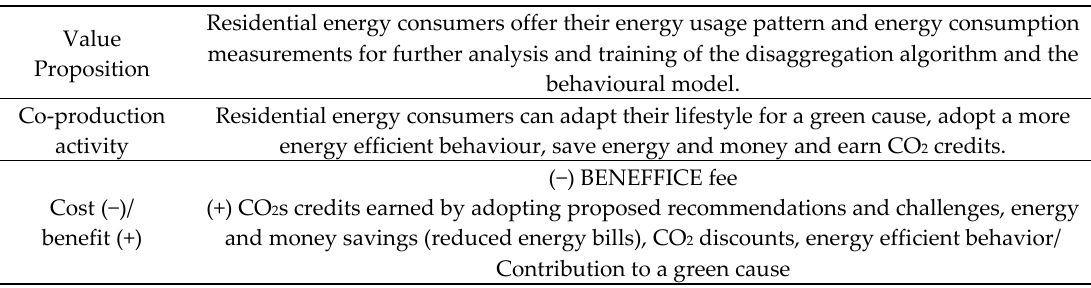
Table 8. Residential Energy